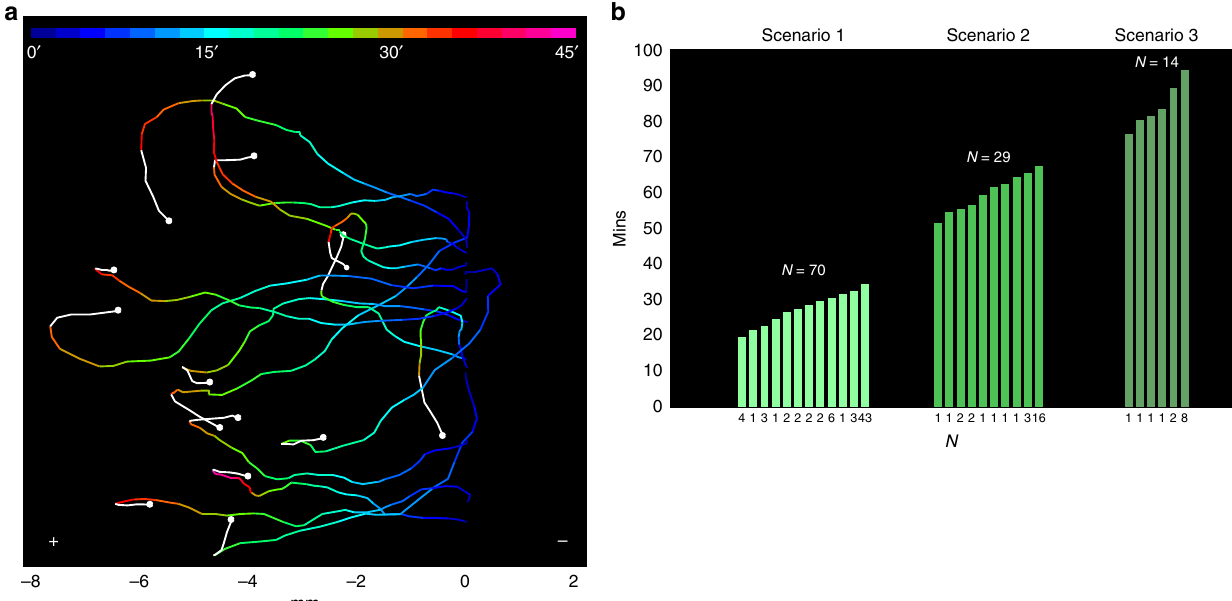
Fig. 7 Persistence time in the conditioned motility patterns of Amoeba proteus . a Trajectories of 15 amoebae under galvanotaxis, that previously acquired the systemic conditioned behavior after induction process, lost gradually the persistence towards the anode (times ranging from 27 to 44 min) and turned back to the cathode (white line). The colors of the trajectories represent the duration of the conditioned behavior, as is indicated in the top of the fi gure. b Histogram representing the durations of the conditioned behavior for the fi rst, second, and third scenarios. The persistence times ranged between 20 and 95 min. The cells that lost the persistent conditioned behavior at the beginning of the tests were not represented. The three scenarios were shaded in different green tones for better